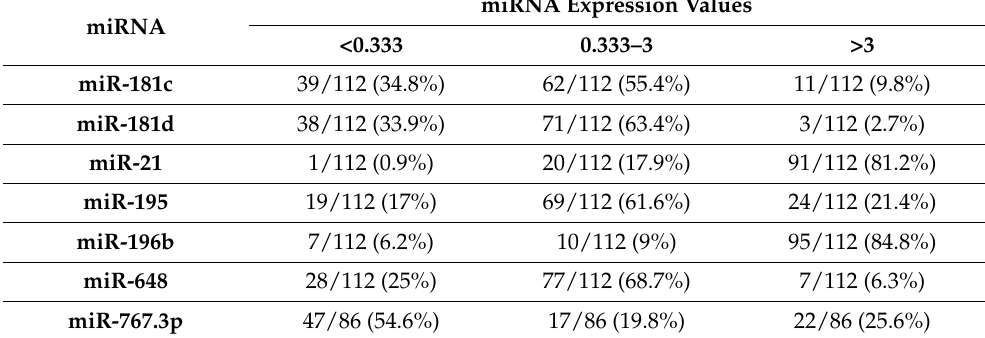
Table 2. miRNA distribution.